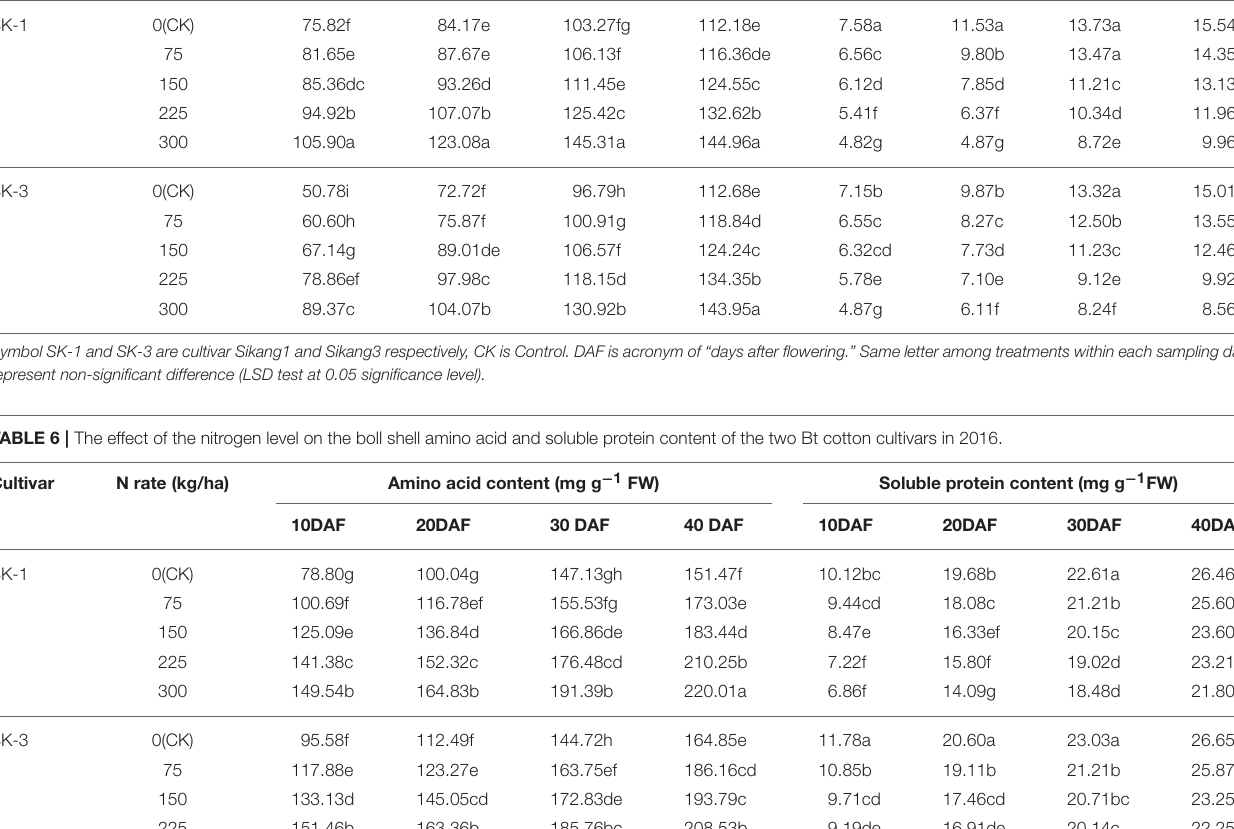
TABLE 7 | The effect of the nitrogen level on the boll shell glutamic-pyruvic transaminase (GPT) and glutamic-oxalacetic transaminase (GOT) activities of the two Bt cotton cultivars in 2015. Cultivar